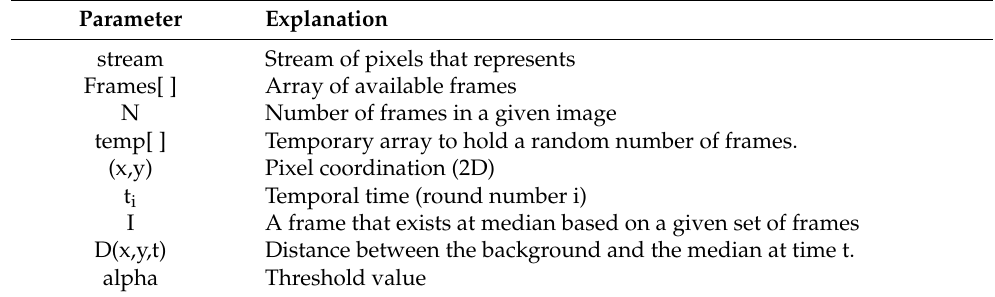
Table 1. Algorithmic